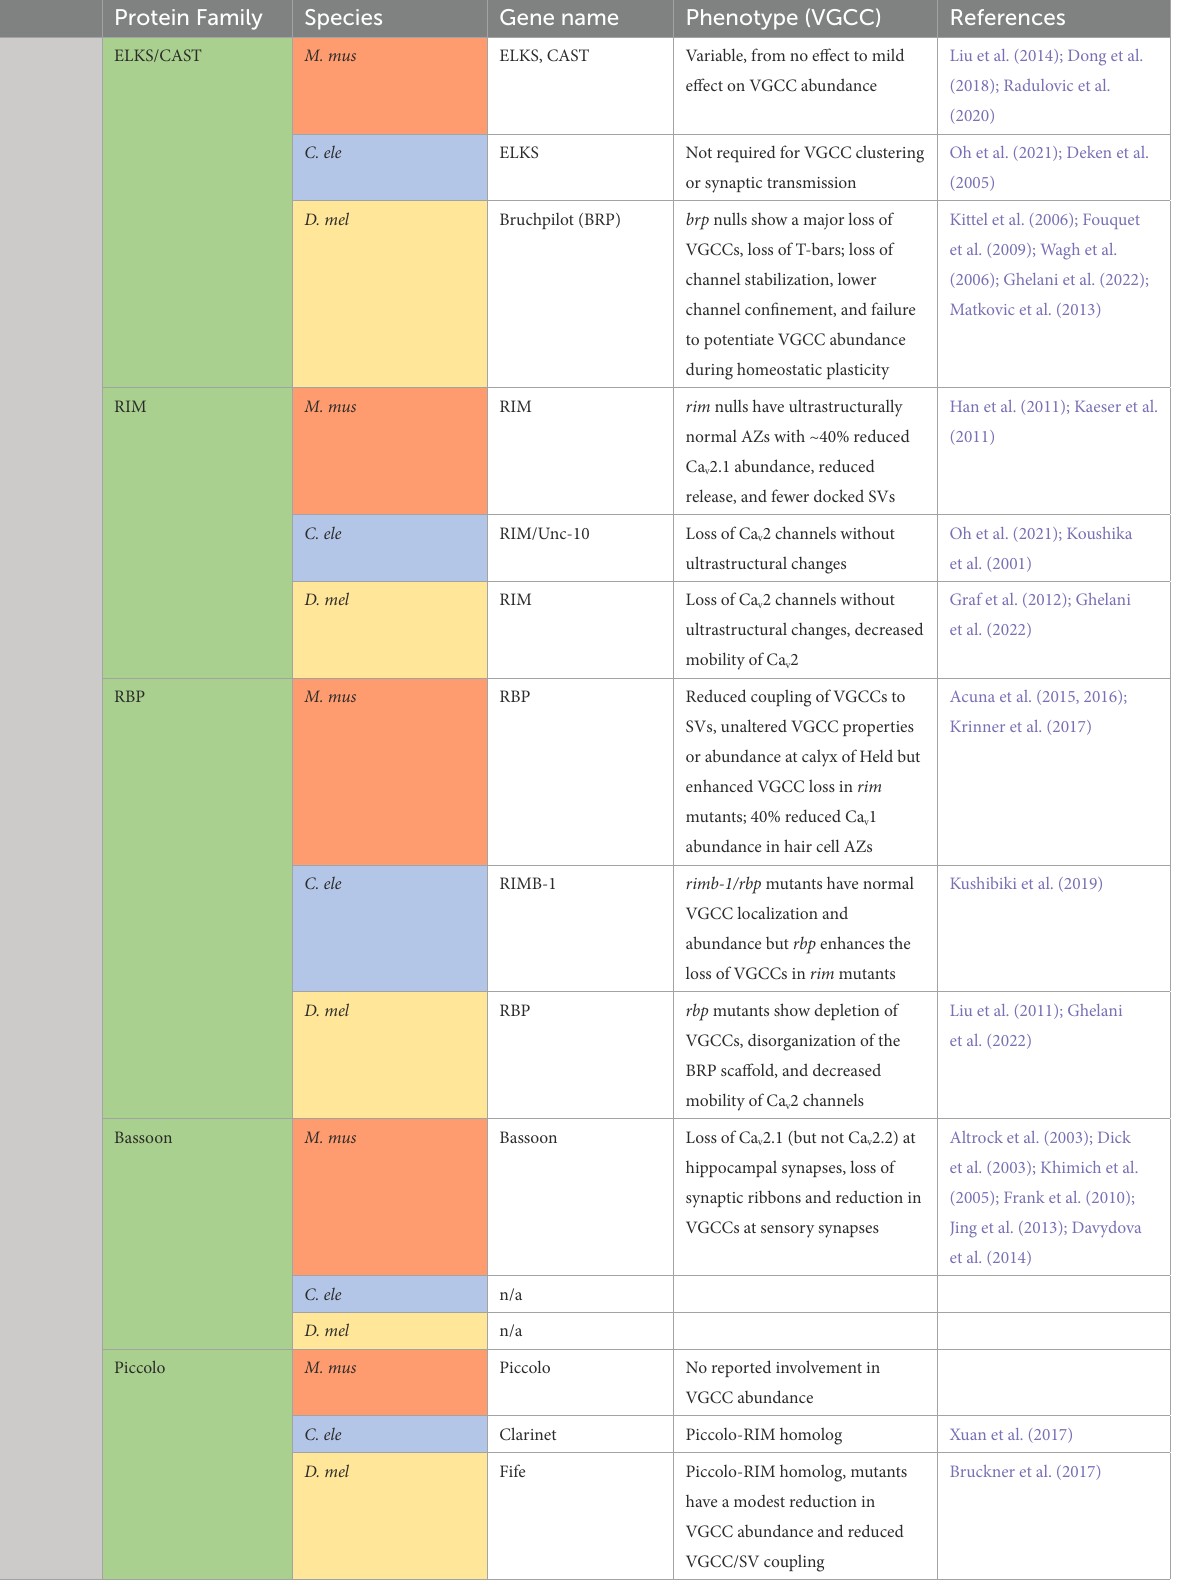
TABLE 1 Summary of AZ structure and VGCC localization/abundance phenotypes in Mus musculus ( M. mus ), Caenorhabditis elegans ( C. ele ), and Drosophila melanogaster ( D. mel ) AZ and VGCC mutants.